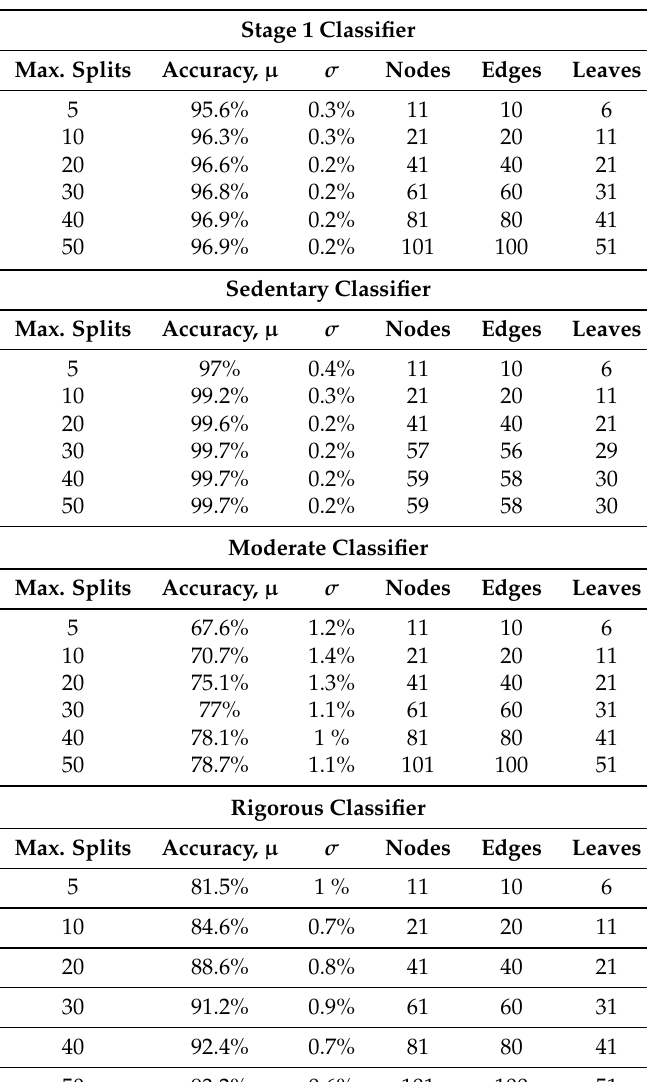
Table 4. On-Board Classification (effect of reduction of